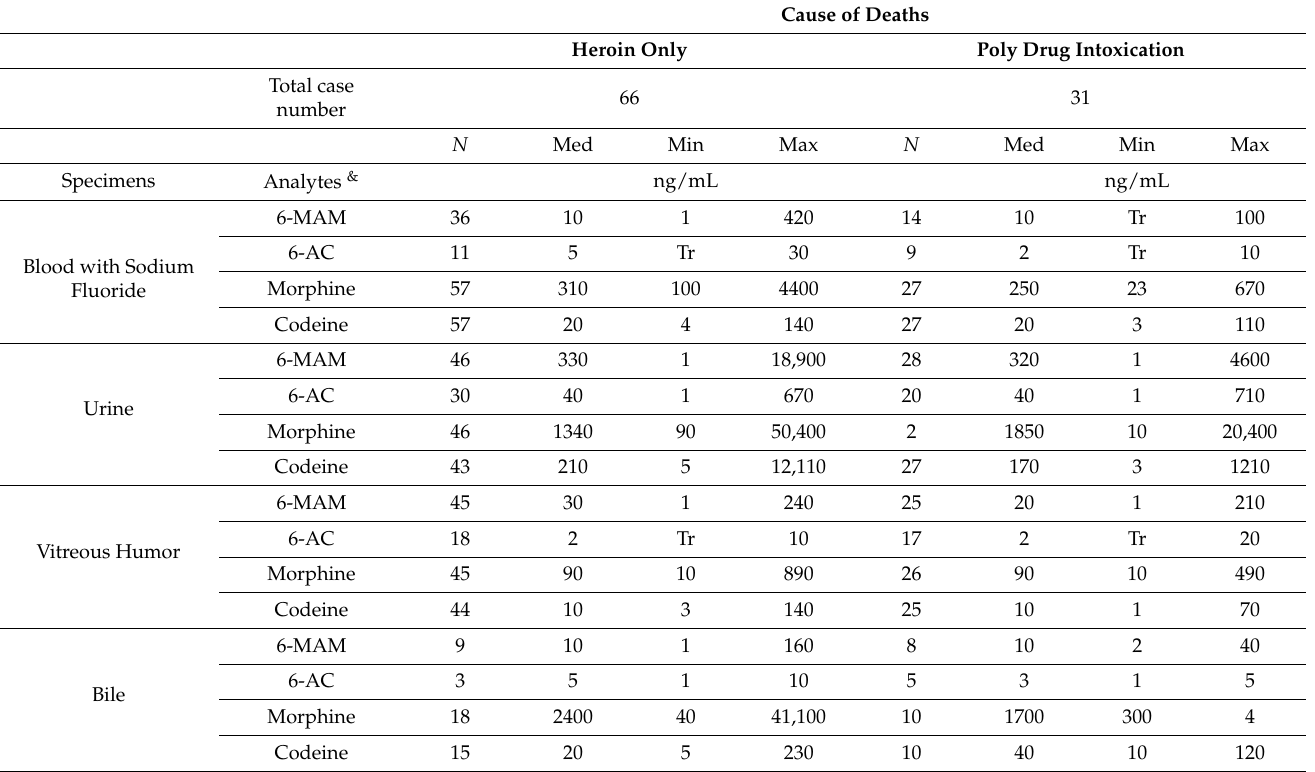
Table 2. Heroin biomarkers, morphine, and codeine concentration in relation to cause of death in the current